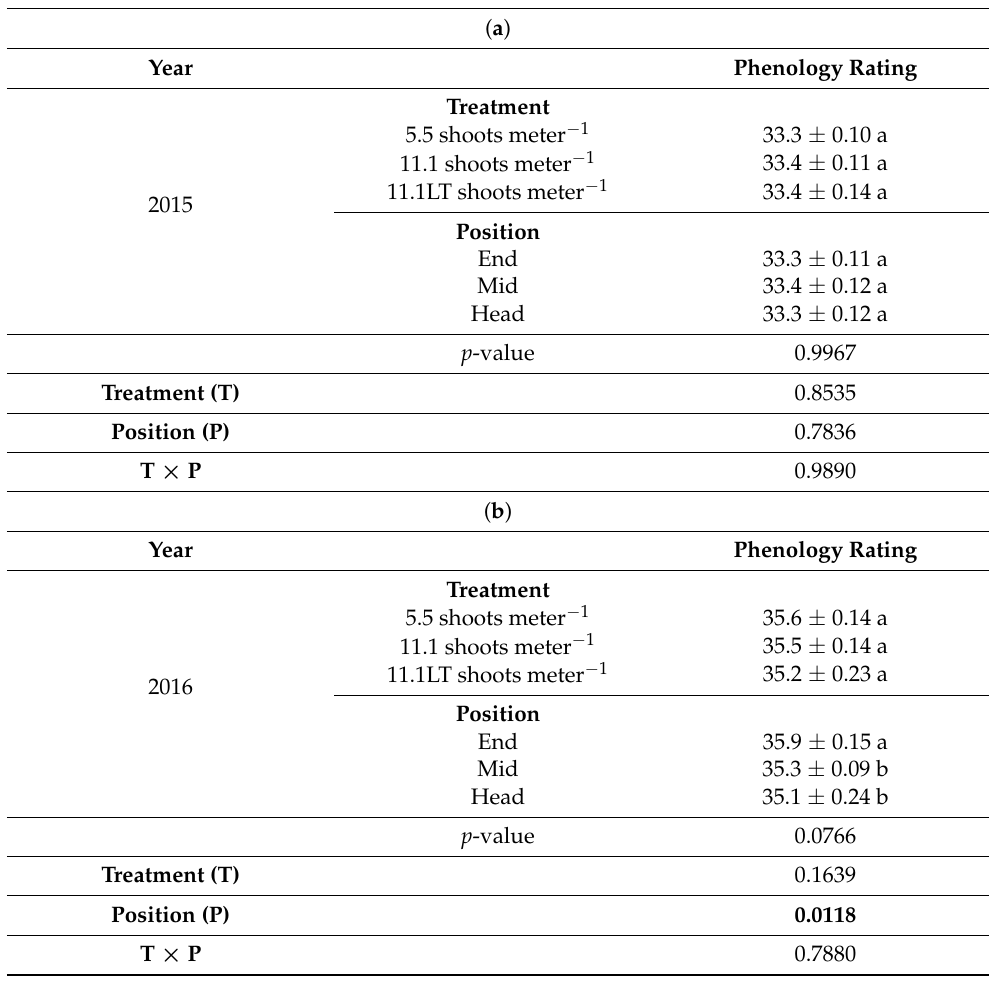
Table 6. Two-way analysis of variance (ANOVA) with interaction showing average phenology ratings by year, treatment, and cordon position at v é raison during the 2015 ( a ), 2016 ( b ), and 2017 ( c ) growing seasons ( n = 8). Table shows treatment means followed by the standard error of the mean. Different letters within a column indicate significant differences based on an Each pair, Student’s t -test. Significant p -values (<0.05) are displayed in